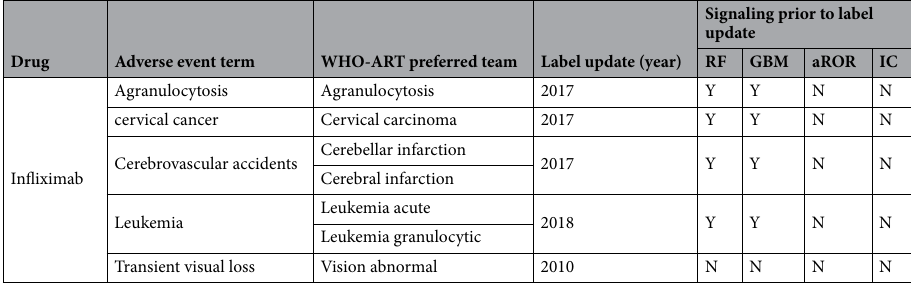
Table 2. Early signal detection results across different data mining methods in the KAERS between 2009 and 2018. KAERS Korea Adverse Event Reporting System, WHO-ART world health organization-adverse reaction